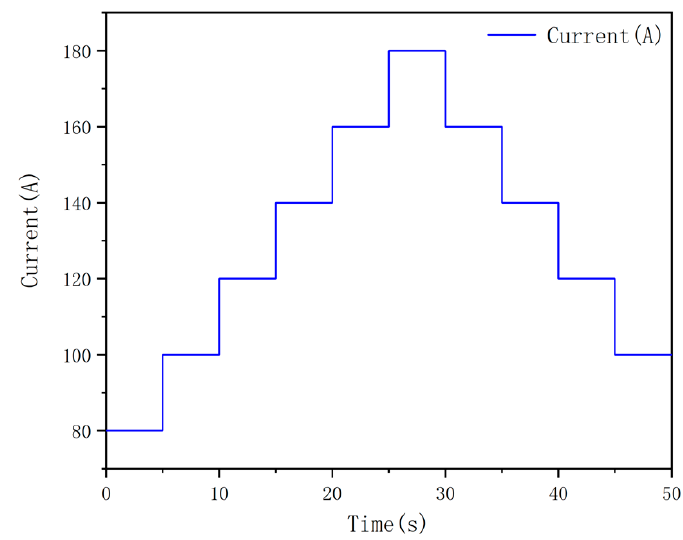
Figure 12. Stack current variation.